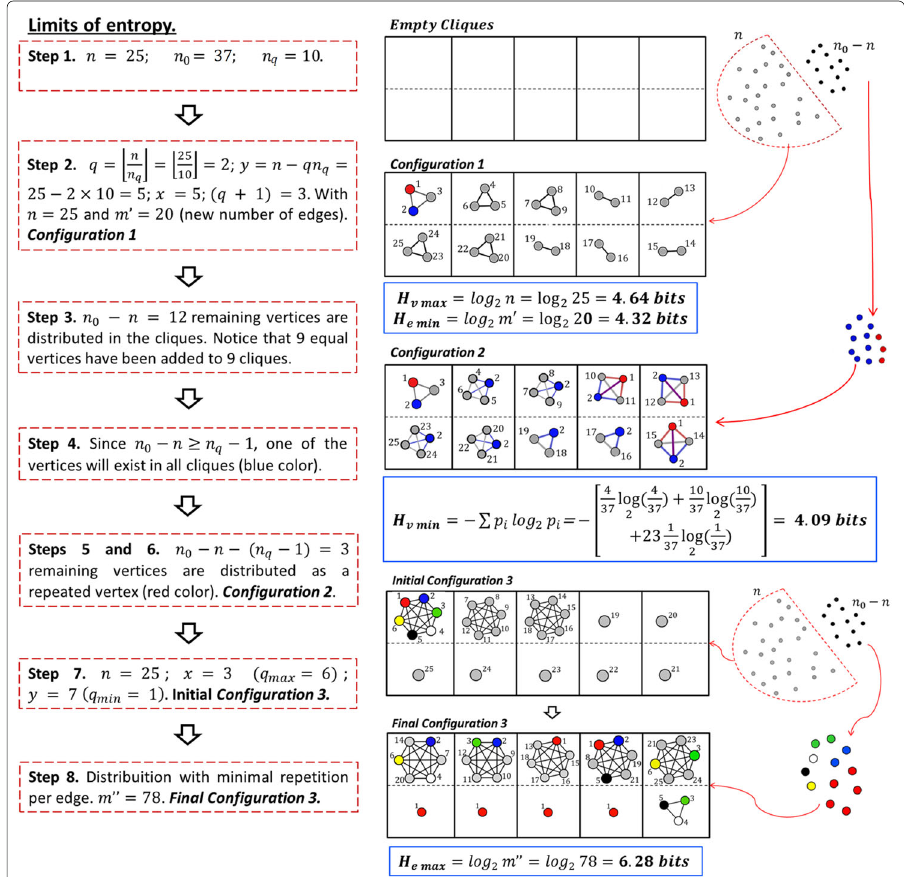
Fig. 5 Step by step of the calculation of the maximum and minimum limits for the entropy values of the vertices and edges of the network of cliques in Fig. 4